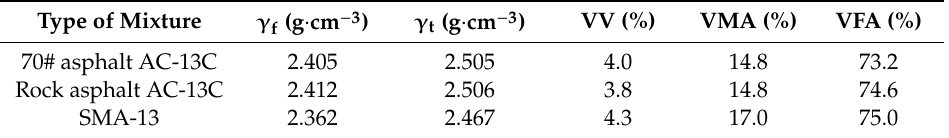
Table 6. Volume indices of the asphalt mixtures.